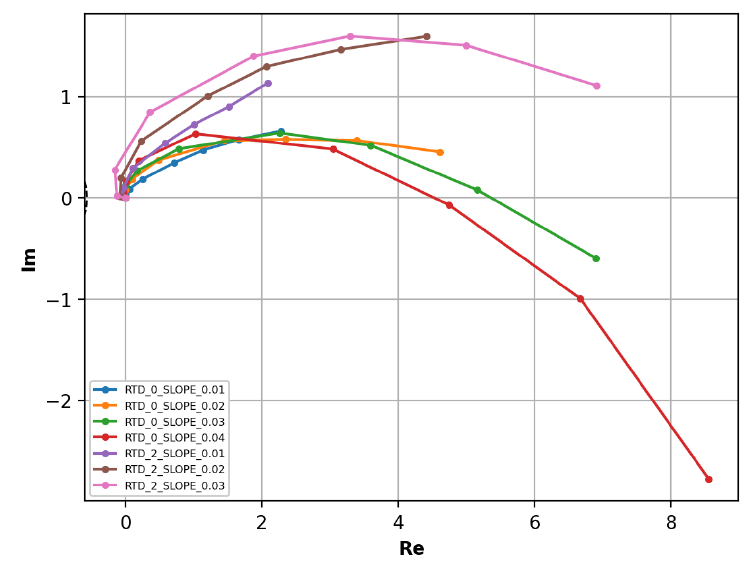
Figure 14. Aggregated plots showing the impact of injected latency and slope of the ramp controller to FCR dynamic stability.